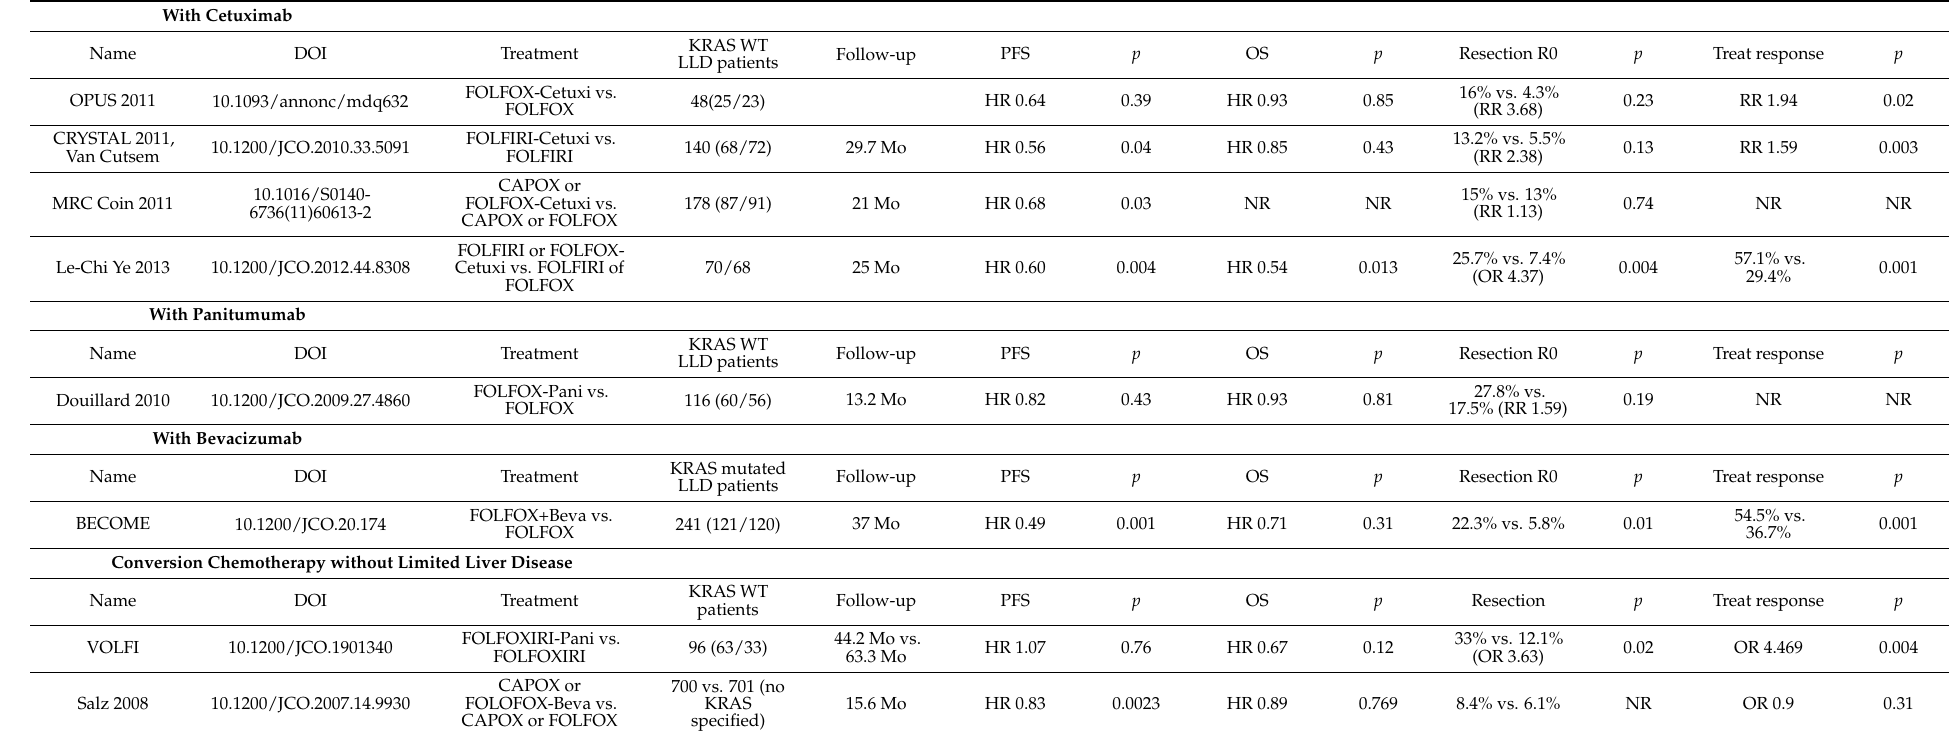
Table 1. Impact of ACM on initially unresectable